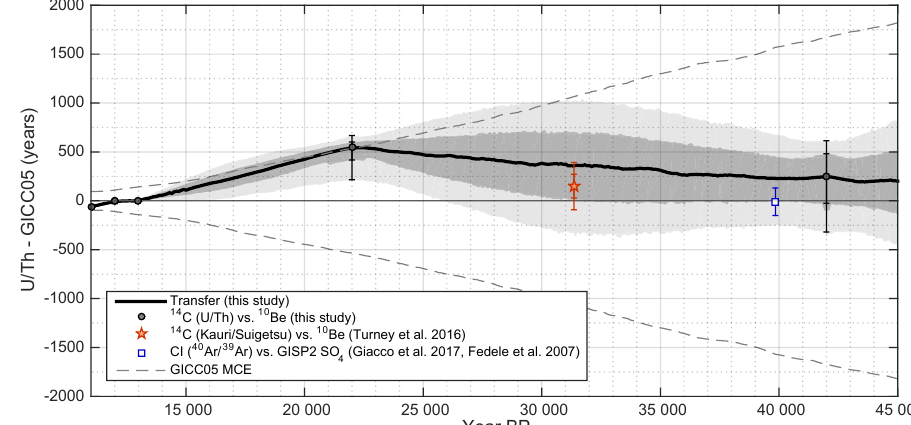
Figure 12. Transfer function between the U / Th timescale and GICC05. The transfer function is shown in black with dark and light grey shading encompassing its 68.2% and 95.4% confidence intervals. The black dots with error bars show the match points used between 14 C and 10 Be. The red star shows the difference between ages of a glacial kauri tree 14 C sequence on Lake Suigetsu 14 C and GRIP 10 Be (Turney et al., 2016). The blue open square shows the age difference between the 40 Ar / 39 Ar age of the Campanian Ignimbrite (Giaccio et al., 2017) and a tentatively associated spike in the GISP2 SO 4 record (Fedele et al., 2007) on the GICC05 timescale (Seierstad et al.,